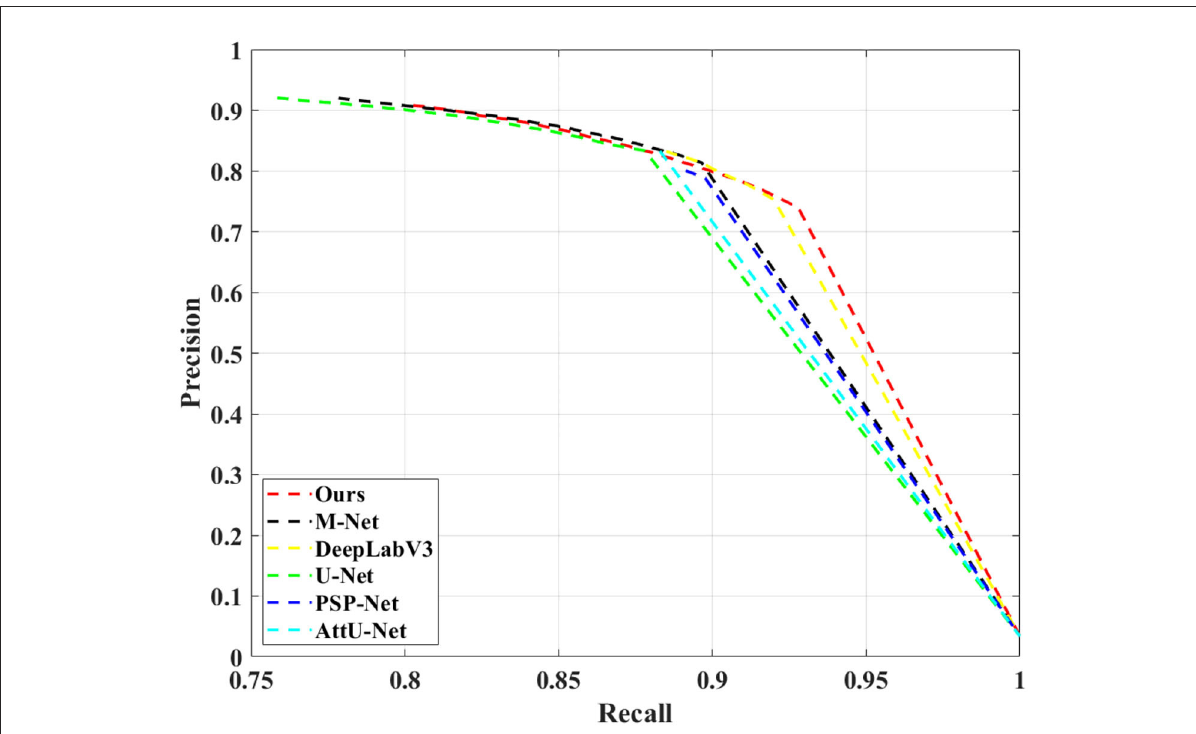
FIGURE5 Comparison of precision-recall curves of our N-Net and other medical image segmentation approaches on the TNUI-2021 dataset.